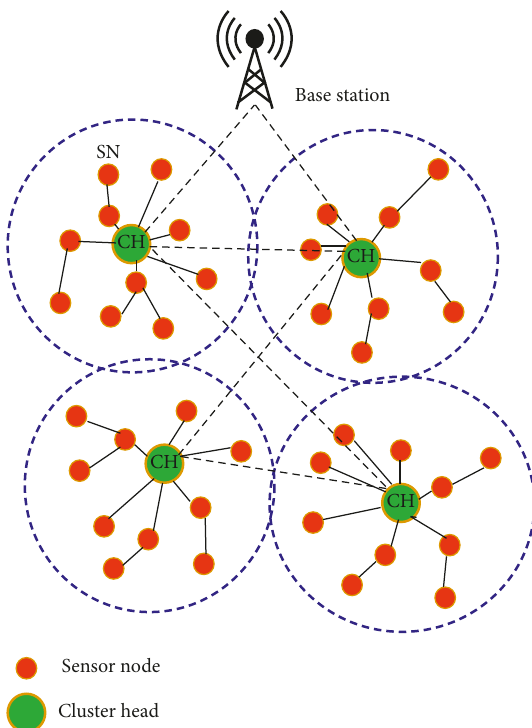
Figure 1: A wireless sensor network with CHs, BS, and